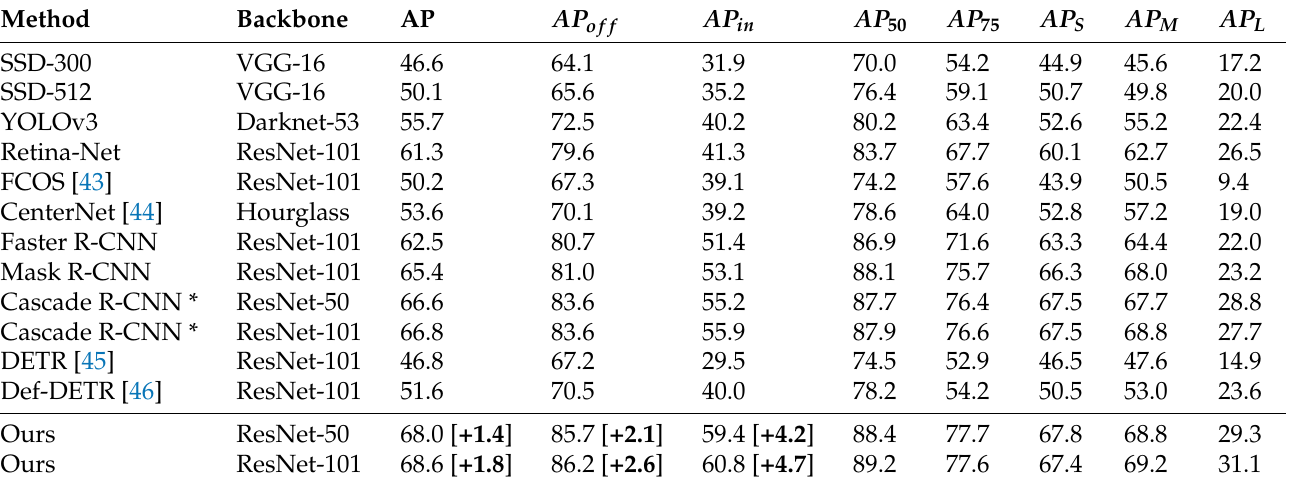
Table 2. Comparison results on